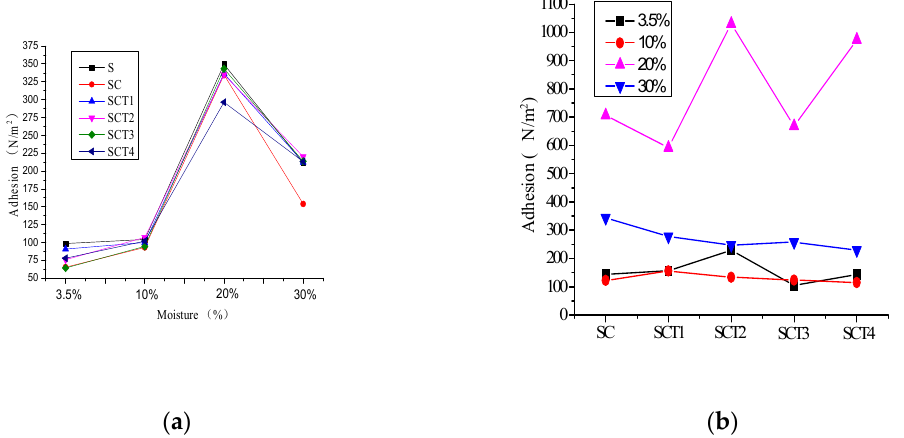
Figure 6. Adhesion test results under different moistures: ( a ) friction force between functioning surface and the soil, ( b ) soil adhesion.